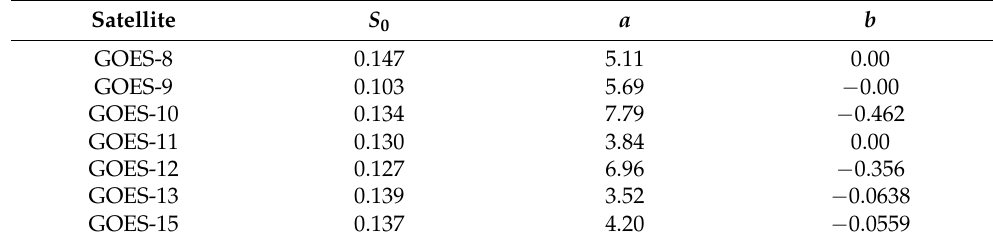
Table A2. NASA Langley CERES Ed4 GOES-IP calibration expressed in the PATMOS-x format. The NASA Langley CERES Ed4 calibration for GOES-9 is applicable only after GOES-9 was moved out of